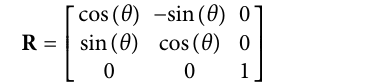
Frontiers in Physiology |